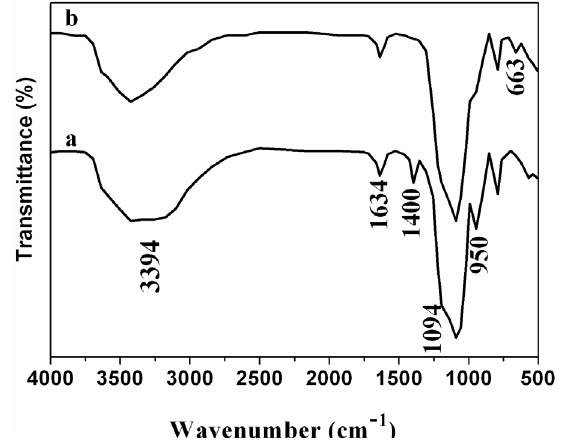
Figure 2. Fourier transform infrared (FT-IR) spectra of parent ( a ) Silica nanoparticles and ( b ) Silica/cobalt hydroxide